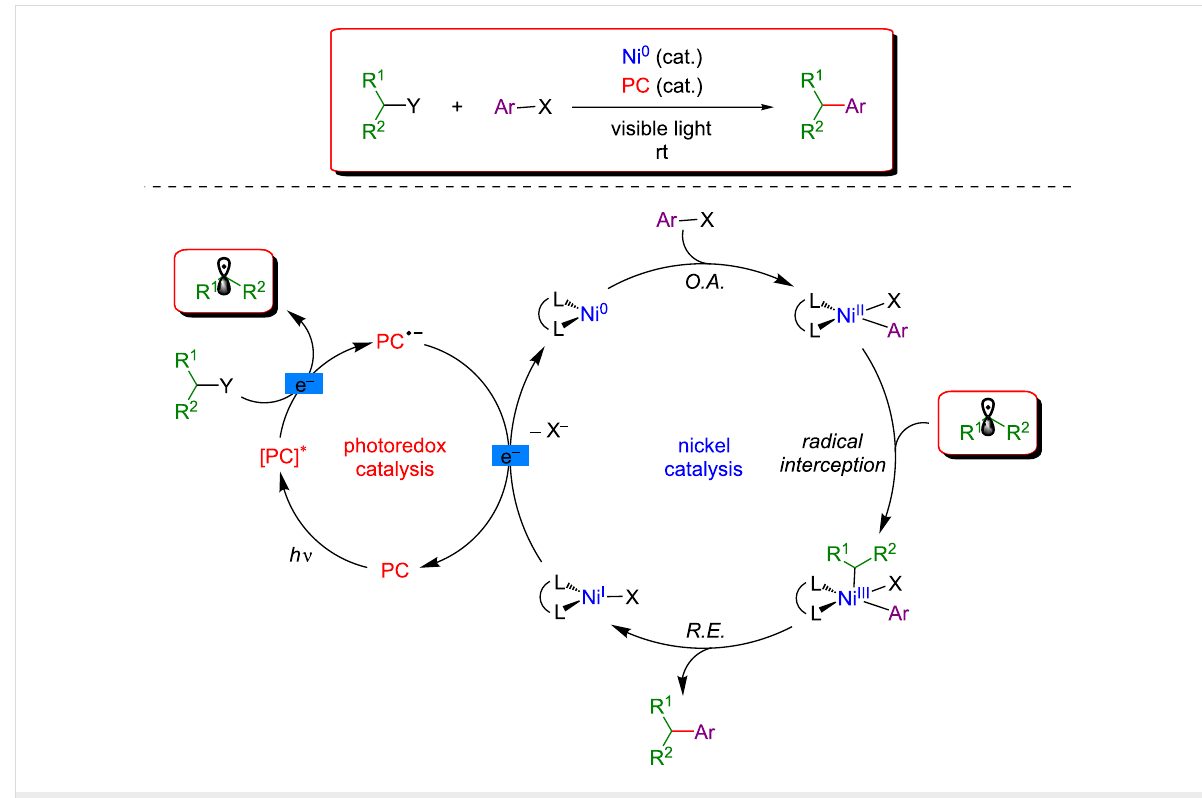
Figure 3: General mechanism for the dual nickel/photoredox catalytic system.